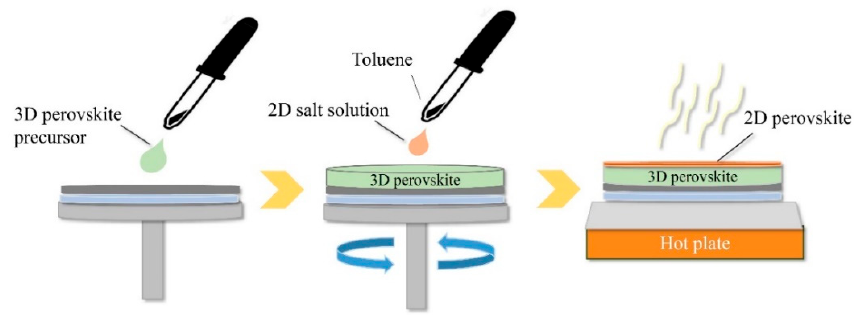
Figure 3. Schematic experimental process of the anti-solvent method.